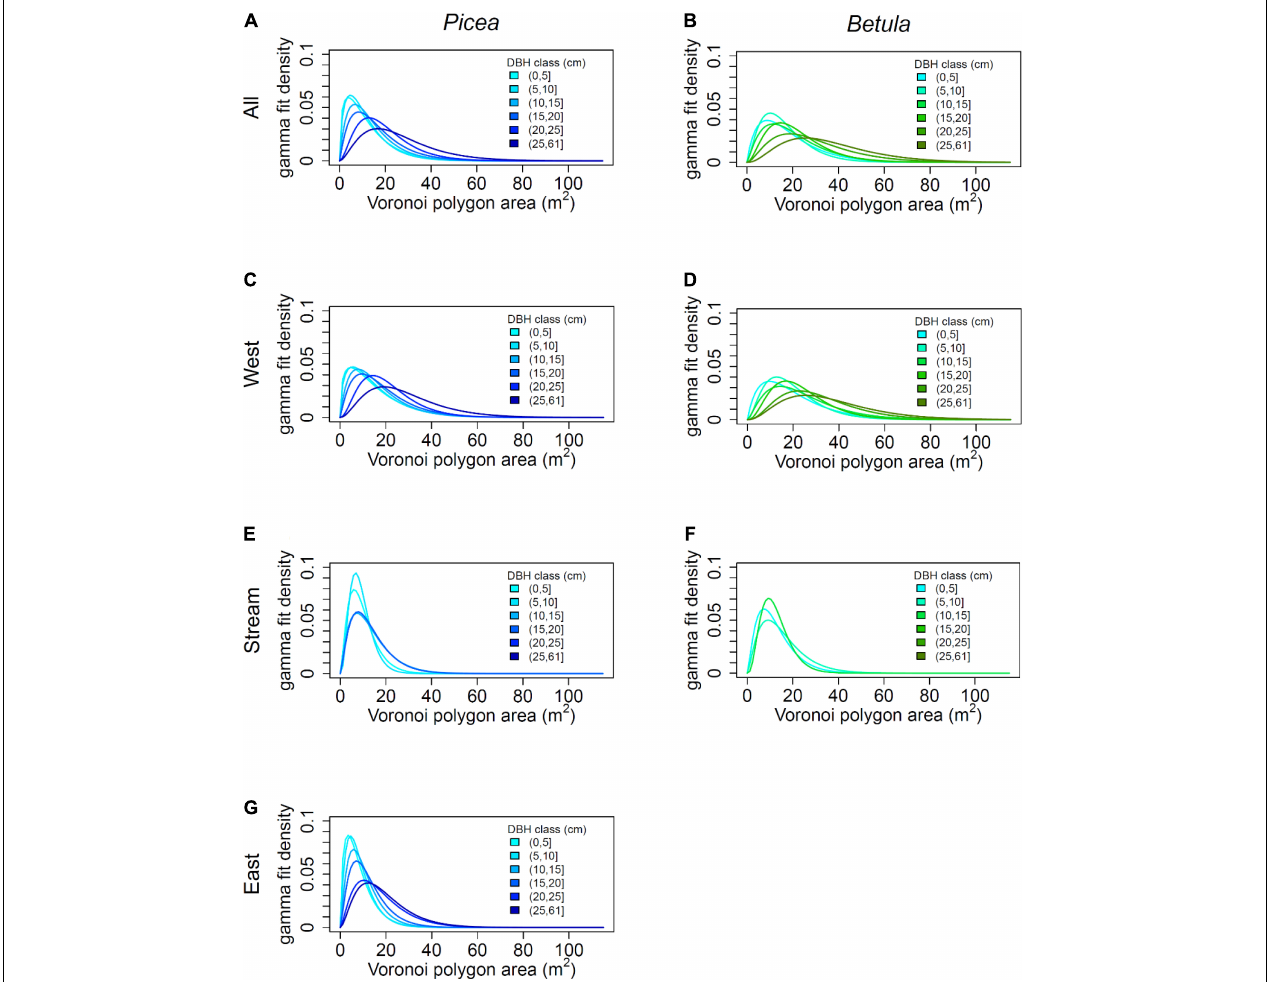
FIGURE 6 | Distribution of space potentially available to trees by diameter at breast height (DBH) and species for the whole plot and the subplots, for combinations with at least 20 trees: (A) All Picea , (B) All Betula , (C) Picea in the West, (D) Betula in the West, (E) Picea in the Stream area, (F) Betula in the Stream area, and (G) Picea in the East. The space available to trees was calculated as the area of the Voronoi polygon of each tree. and the curves represent the fitted gamma distributions when tree growing spaces were classified by tree diameter and